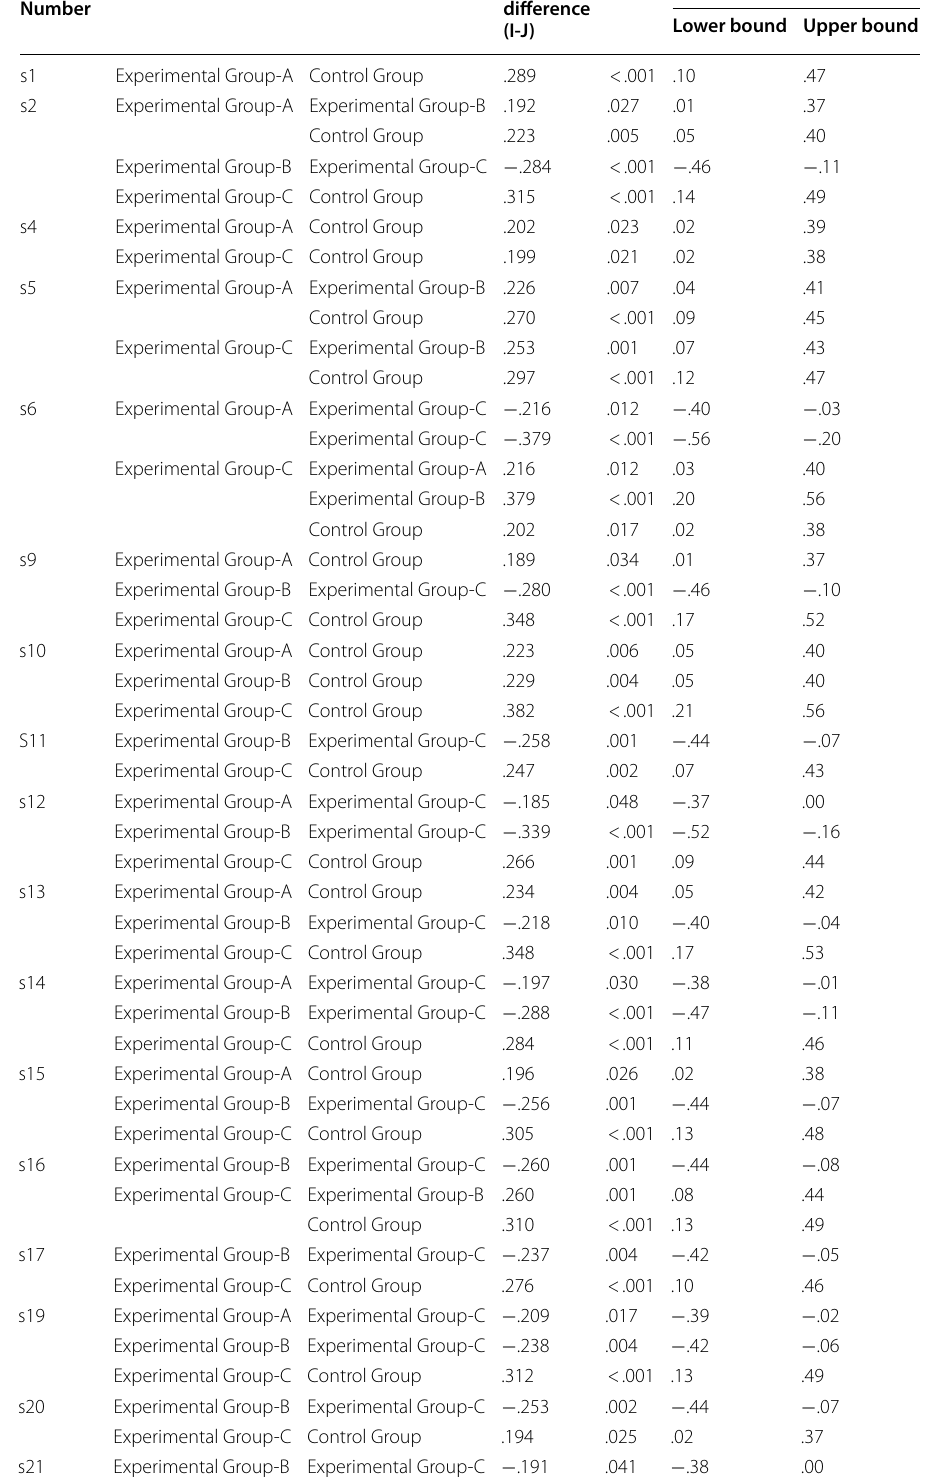
Table 8 Comparison results between groups regarding the answers to the questions in the AAT test Question Group Number